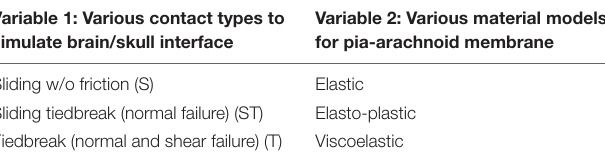
TABLE 2 | Parametric study matrix for improving DCD validation results. Variable 1: Various contact types to simulate brain/skull interface